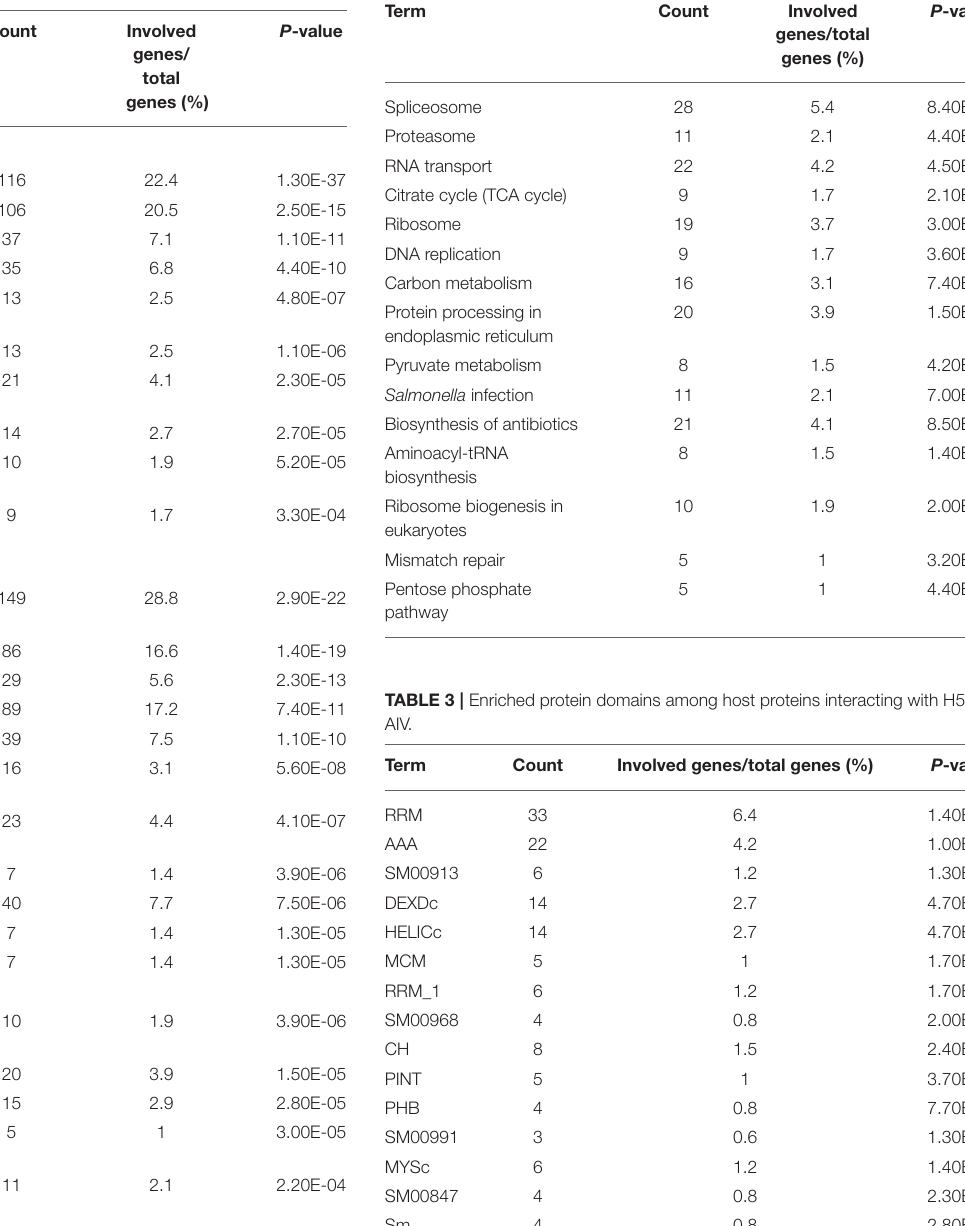
P -value genes/total genes (%)